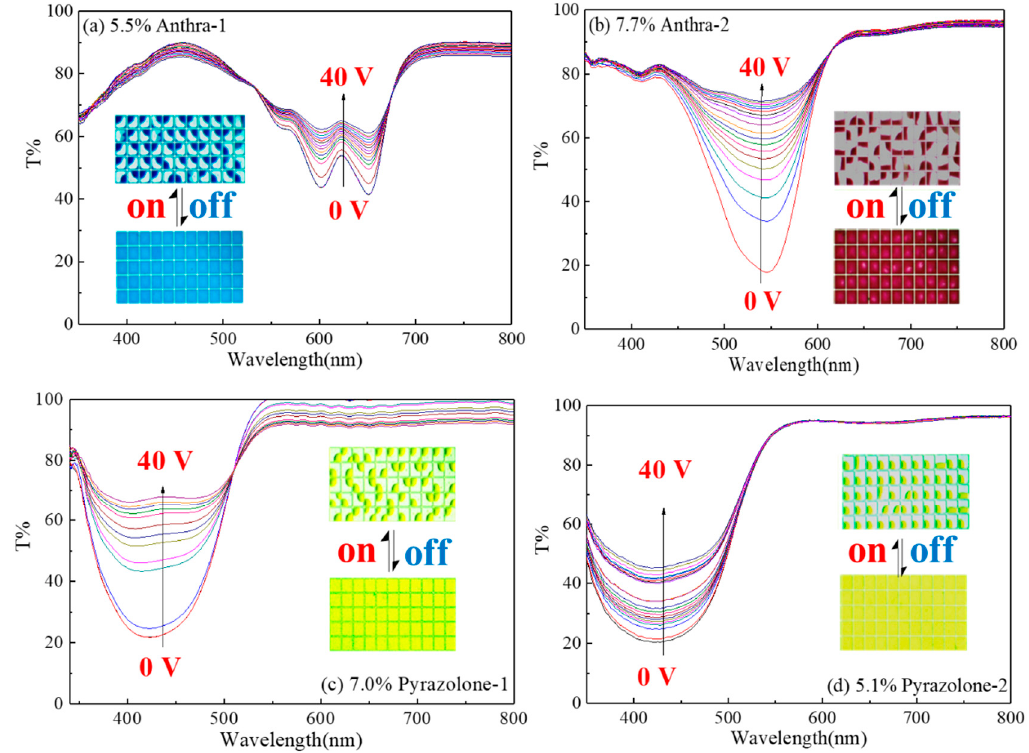
Figure 4. Transmission spectra of EFD display formulated by four formulated dyes under different voltages. (Insert: micron photos of pixels filled with different oils). ( a ) 5.5% Anthra-1, ( b ) 7.7% Anthra-2.